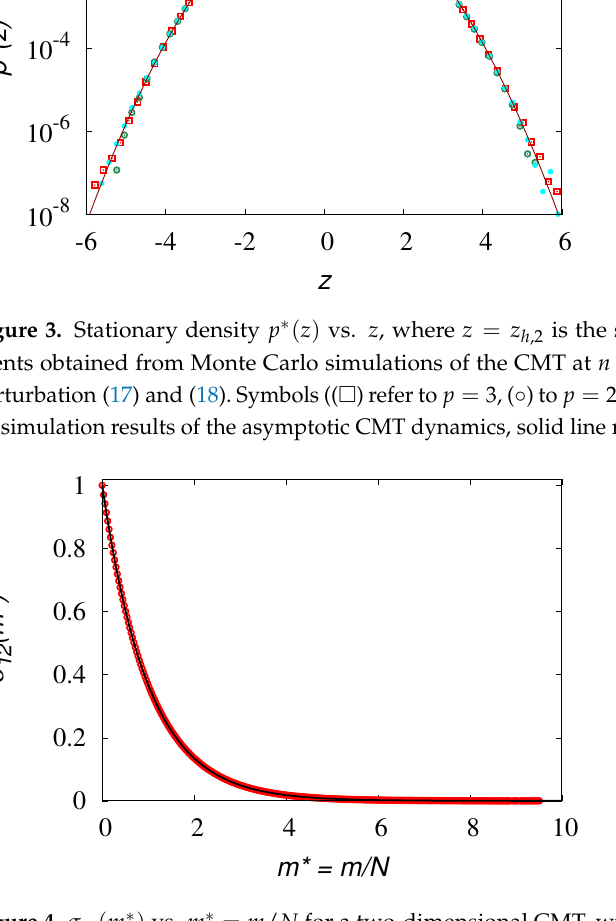
Figure 4. σ 12 ( m ∗ ) vs. m ∗ = m / N for a two-dimensional CMT, with uniformly distributed random perturbations, starting from highly correlated initial conditions Equation (20). Symbols are the results of stochastic simulations, the solid line represents the curve σ 12 ( m ∗ ) = e − m ∗